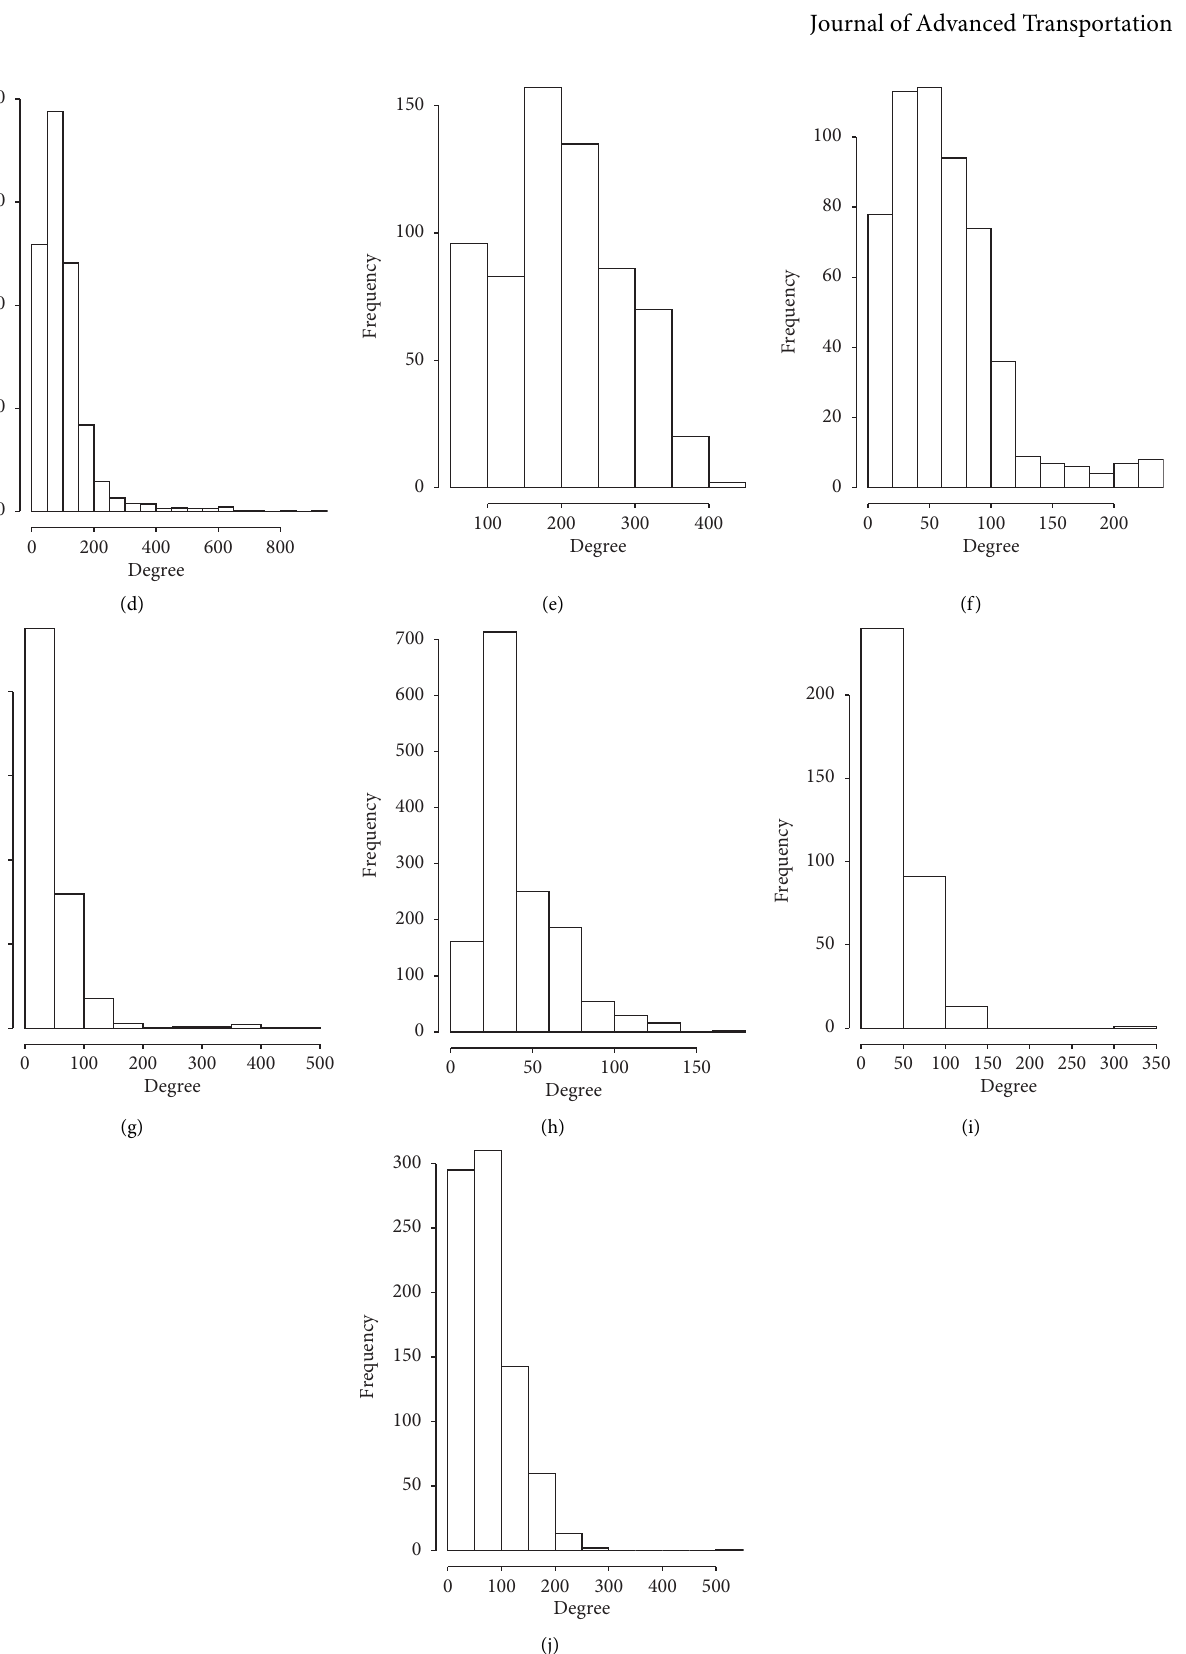
Figure 4: Degree distributions in P-Space in linear ( x -axis) and linear scale ( y -axis) for the following networks: EMT (a), BC Transit (b), Kolumbus (c), Auckland (d), TransAntofagasta (e), Linja-Karjala Oy (f), AVL, CFL, RGTR, and TICE (g), STAR (h), CIT (i), and Thunder Bay Transit